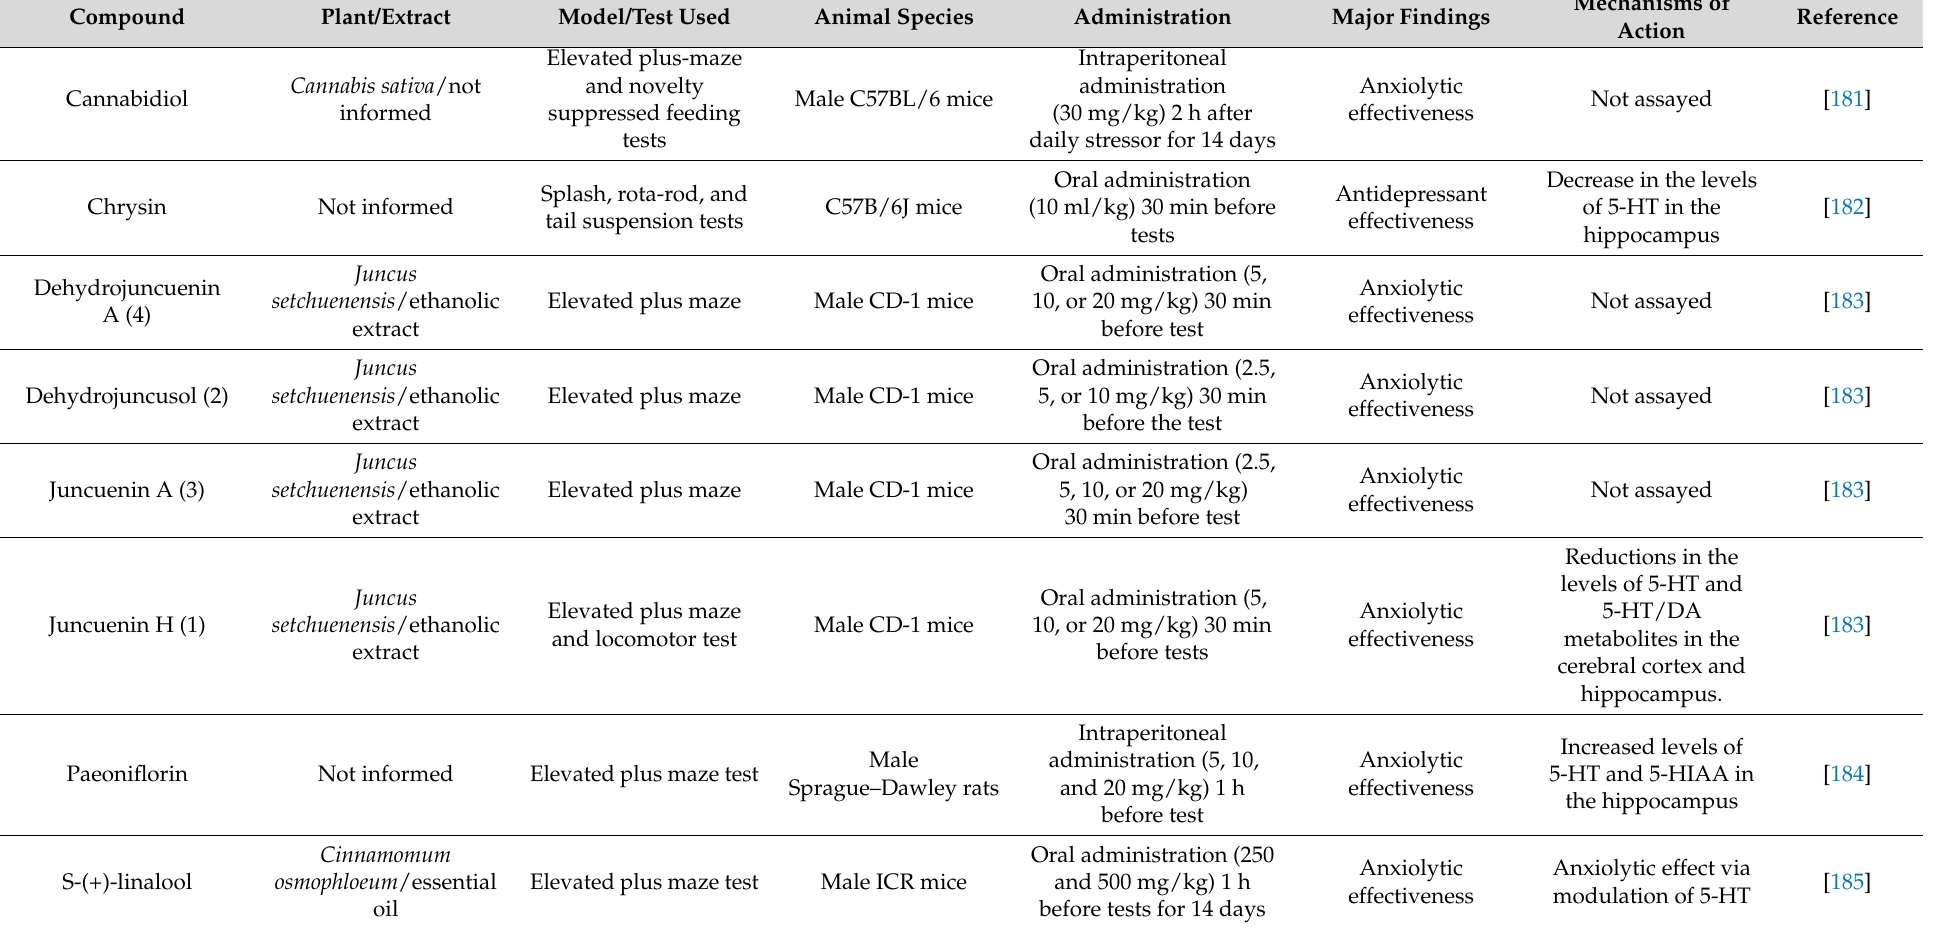
Table 1. Phytochemicals that produce antidepressant-like or anxiolytic-like effects on animal